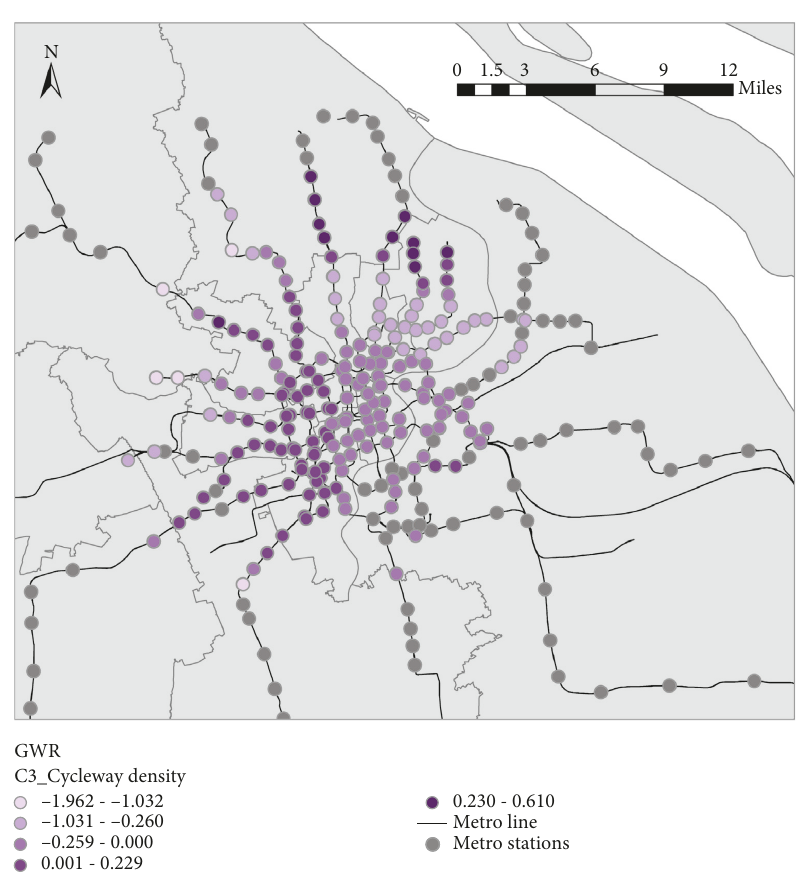
Figure 9: Spatially varying effect of the cycleway density on bike-sharing transfer